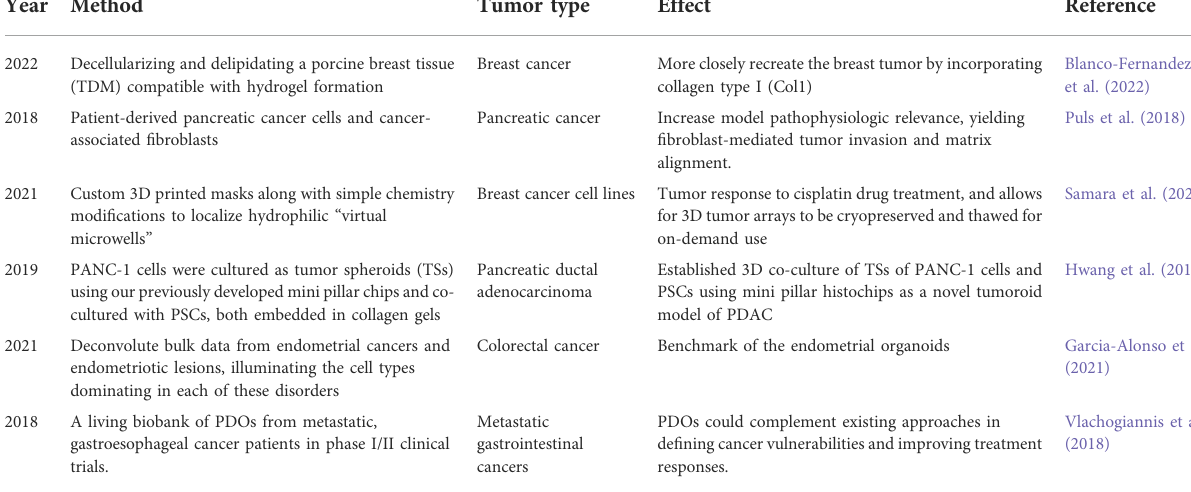
TABLE 2 Preclinical drug evaluation development in 3D tumor